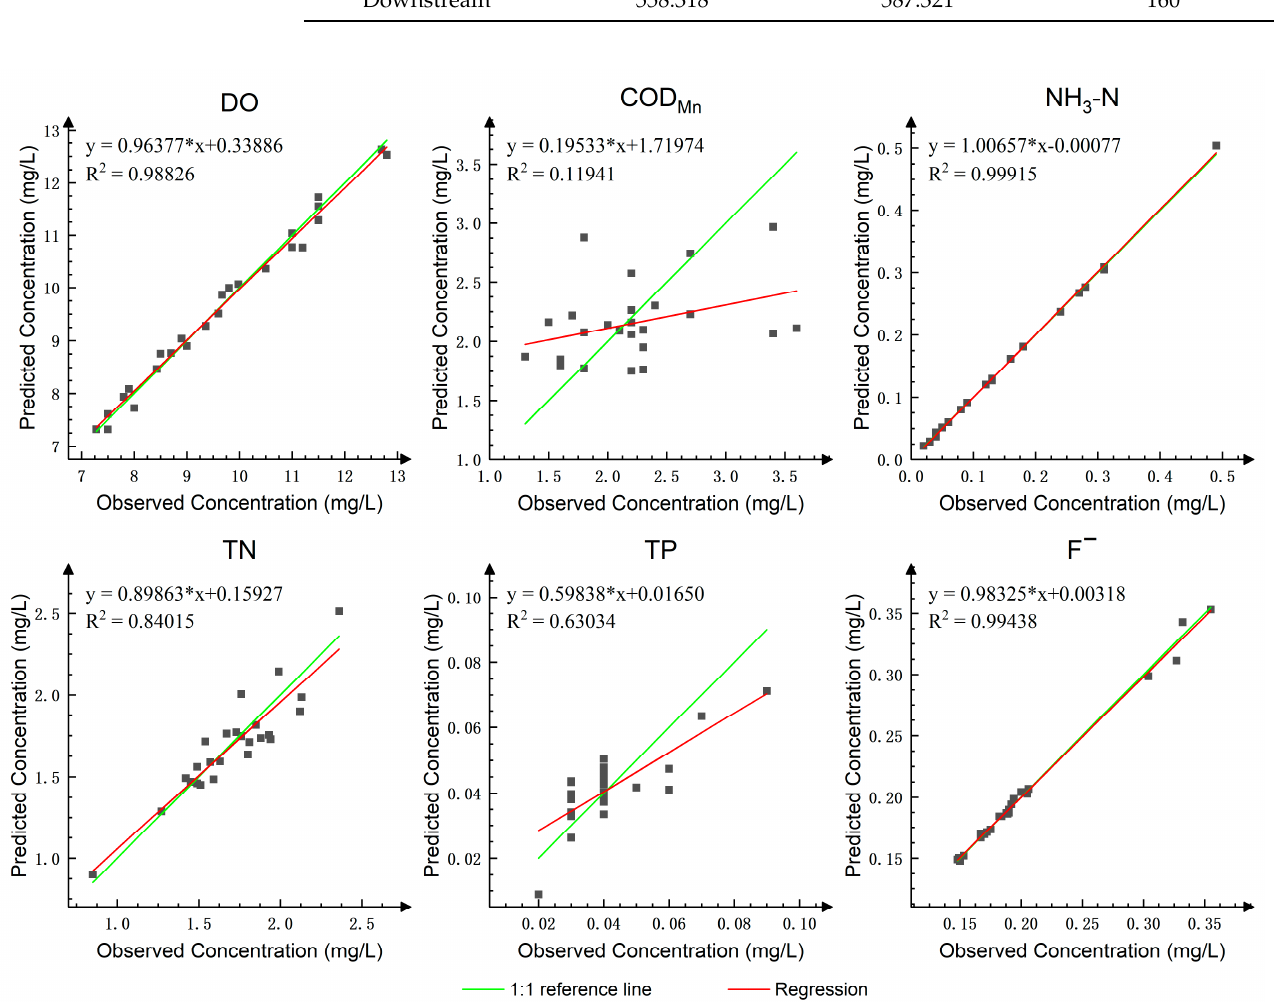
Figure 5. Upstream fitting comparison diagram of observed and predicted concentrations. Green line is the 1:1 reference line and red line is the regression line.